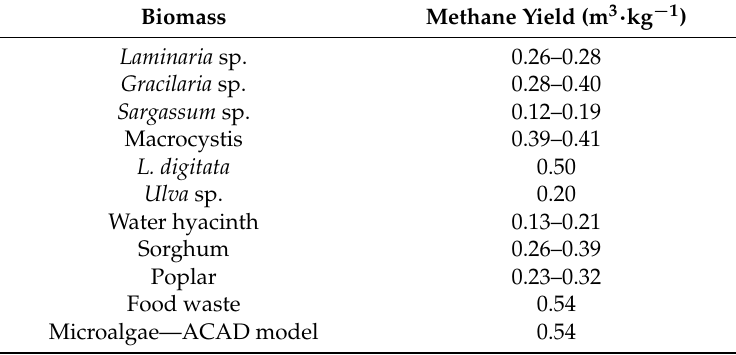
Table 7. Yield of methane from various feedstocks. Used with permission from